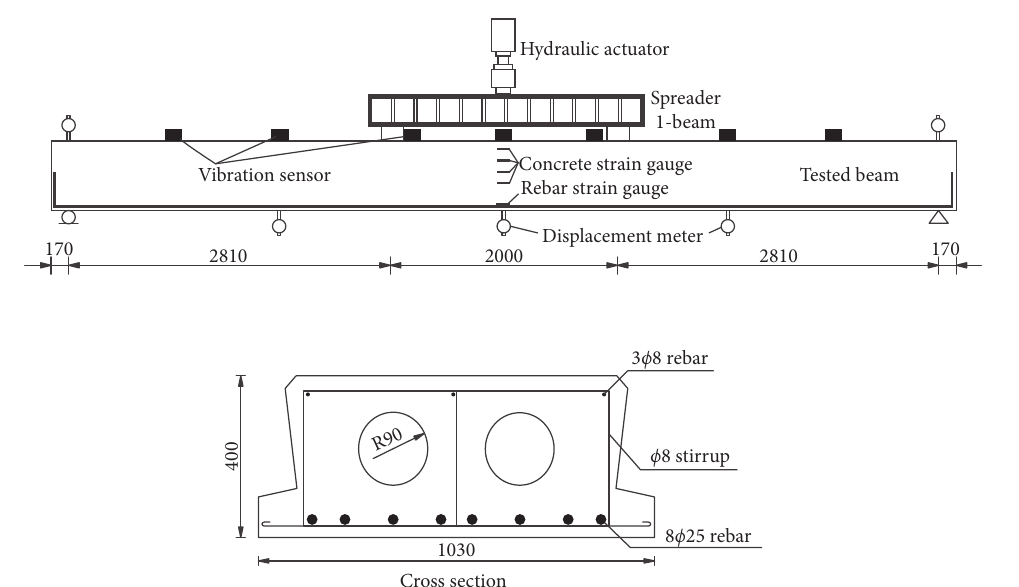
Figure 5: Beam details and experimental setup (unit: